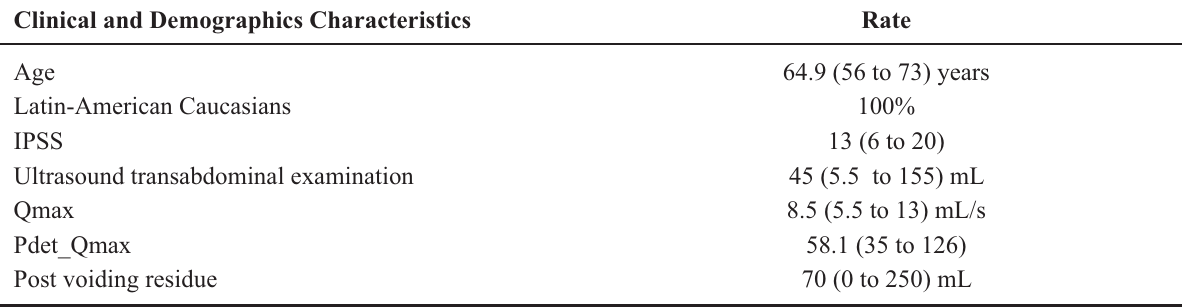
Table 1 – Clinical and demographic characteristics.